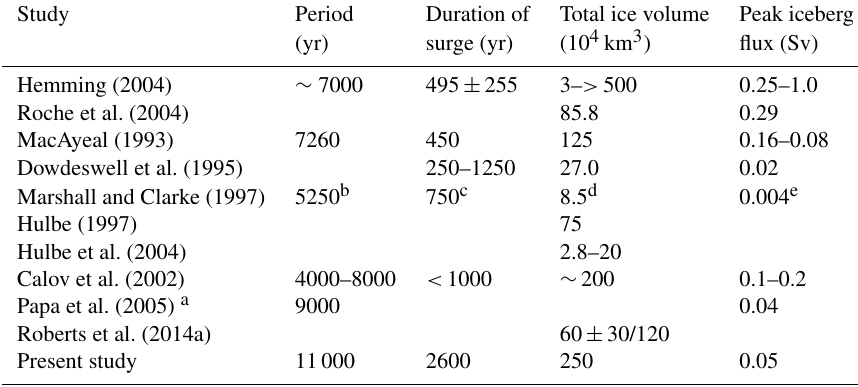
Table 1. Table of vital statistics of Heinrich events from various studies.